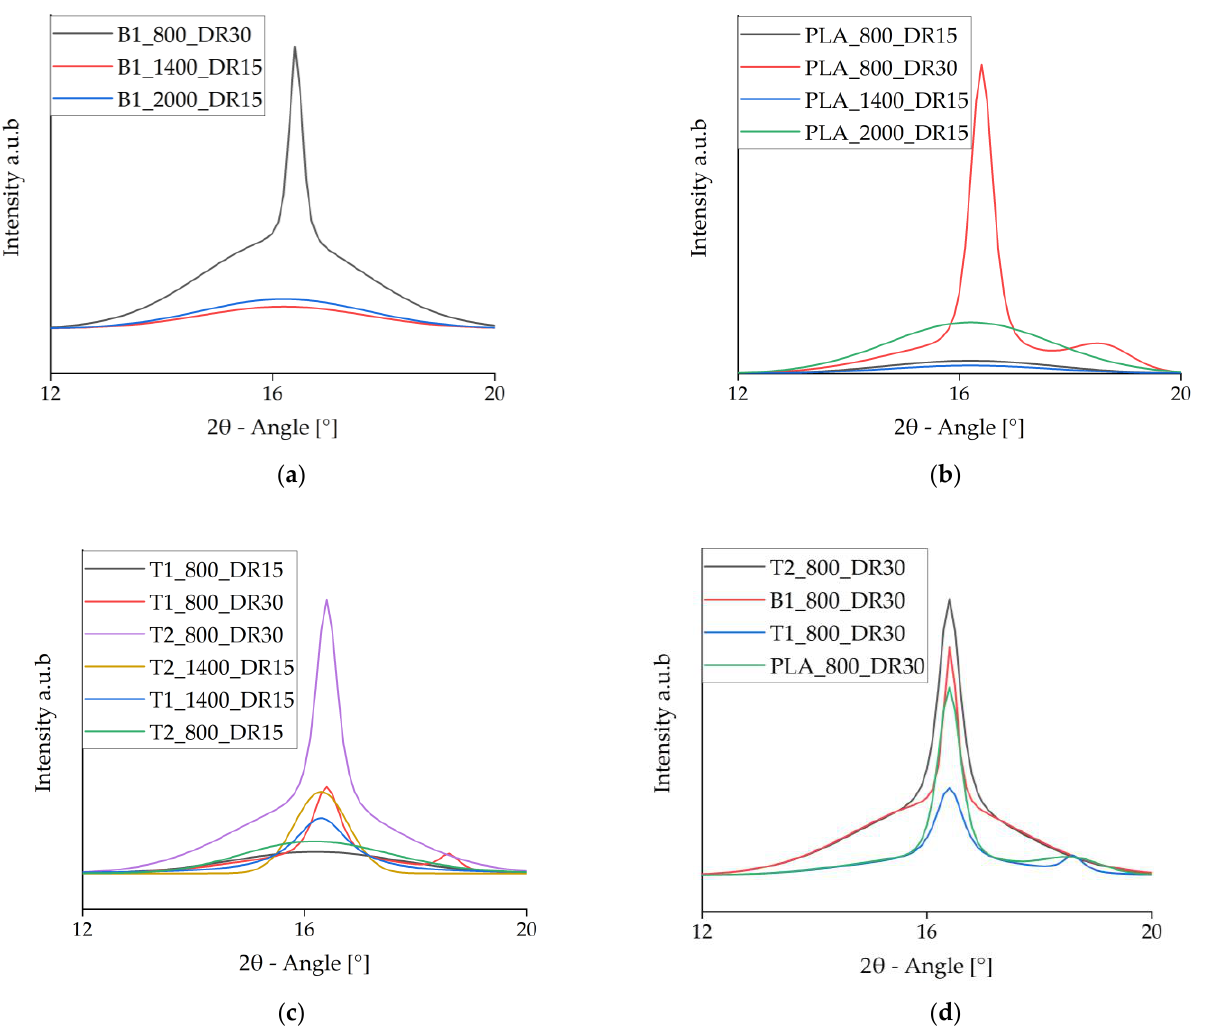
Figure 11. Intensity vs. 2θ curves of the crystalline phase at 2θ = 16.4° from deconvoluted wide-angle X-ray diffraction data. ( a ) Samples containing BHET. ( b ) Pure PLA samples. ( c ) Samples containing talc. ( d ) Comparison of pure PLA and samples containing each nucleating agent.